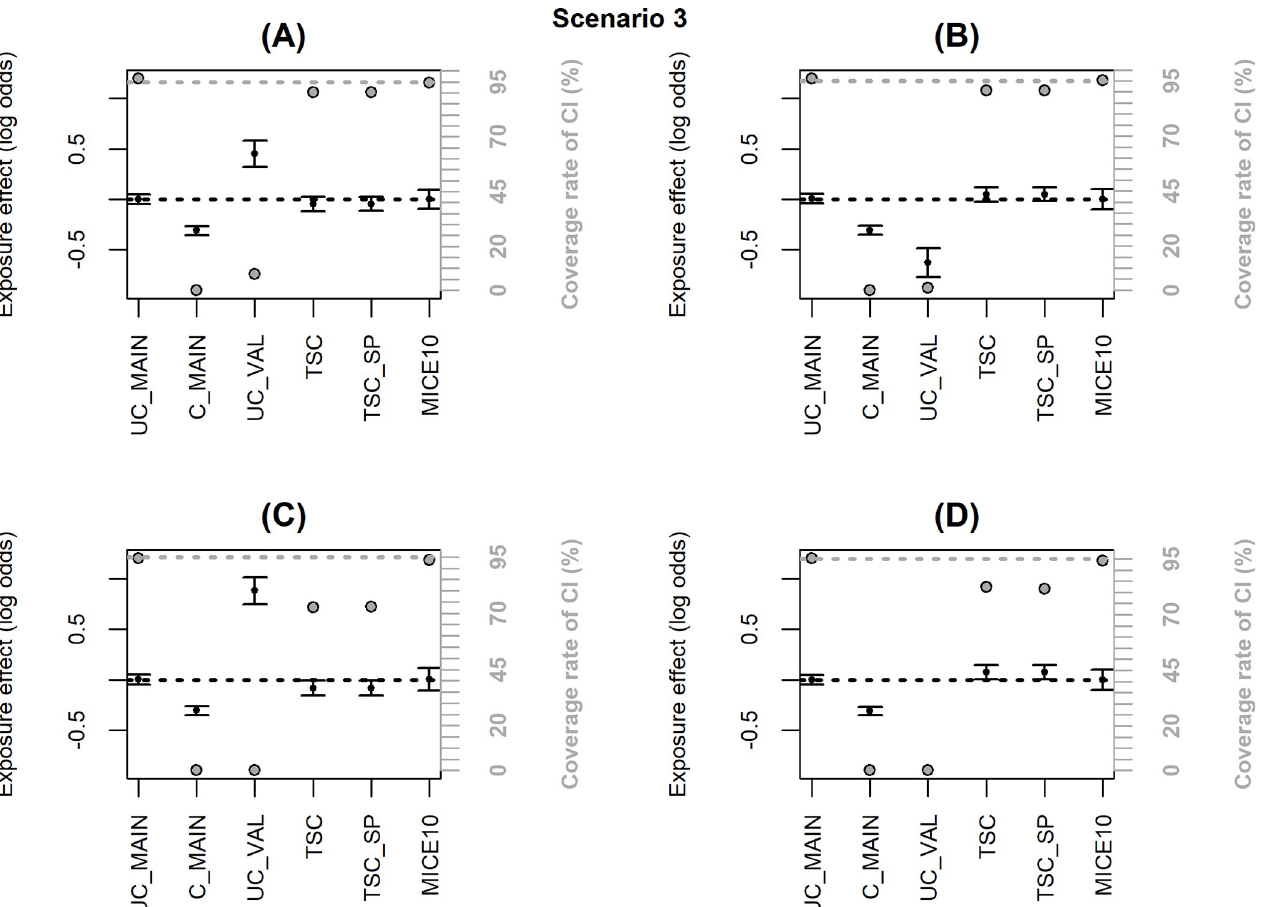
Fig 5. Simulation results with a non-representative internal validation sample where the inclusion probability (notated P) depended on X � Y (scenario 3); coverage rate of 95% confidence interval (grey dot with black margin) and estimated log-odds ratio for the exposure effect (black dot) ± empirical standard error: (A) logit(P) = − 2.7+log2X+log2Y+log2X � Y, (B) logit(P) = − 2.5+log2X+log2Y − log2X � Y, (C) logit(P) = − 2.8+log2X+log2Y+log4X � Y, (D) logit (P) = − 2.4+log2X+log2Y − log4X � Y. The grey dotted line corresponds to the nominal value of the coverage rate of the 95% confidence interval. The black dotted line is the true value of β